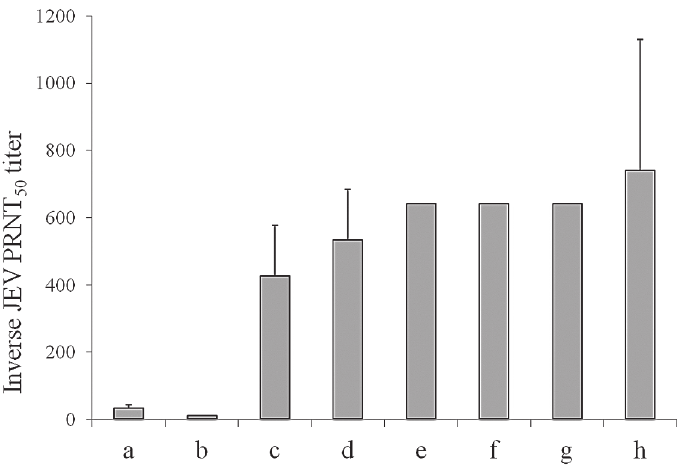
Fig 2. Anti-JEV neutralizing antibody in commercially available IVIG. Mean and standard deviation of reciprocal 50% plaque reduction neutralization titres (PRNT 50 ) in vero cells using P3 wild type strain of JEV are shown for a: Serum control from JEV vaccinated individual, b: Vigam (USA), c: Bharat (India) batch 1, d: Hualan (China) batch 1, e: Bharat (India) batch 2, f: Hualan (China) batch 2, g: Sichuan (China), h: Reliance